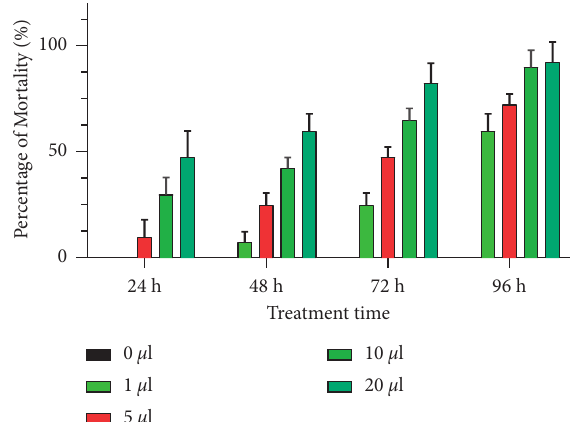
Figure 6: Mortality rate of Callosobruchus maculatus Fab. adults exposed to the inhalation test of Dittrichia viscosa L. essential oils.